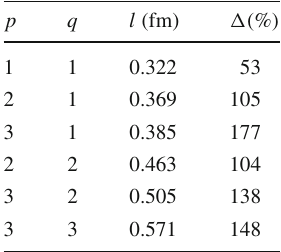
Table 2 Deviation from the topological bound for several values of p and